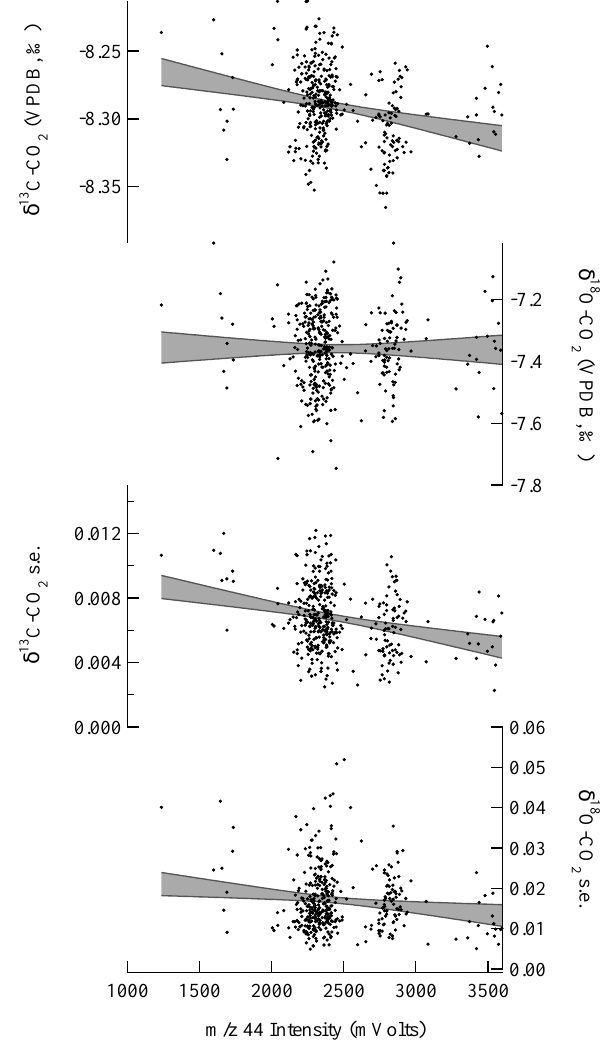
Figure 4. Linearity and precision of standard measurements: the linearity and internal precision of the measurement versus m/z 44 intensity as recorded by measurements of the NOAA1 standard dur- ing the period of analysis. δ 13 C and δ 18 O-CO 2 are reported relative to the working reference gas (upper two panels) and the internal precision is reported as 1 σ standard error of the eight dual-inlet measurements (lower two panels). The grey shading represents the 95% confidence intervals for a linear fit to the